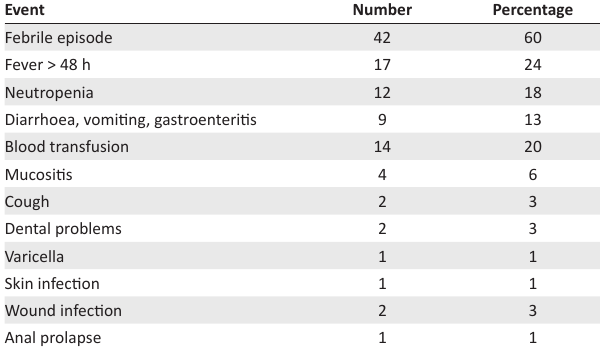
TABLE 3: Morbidity during